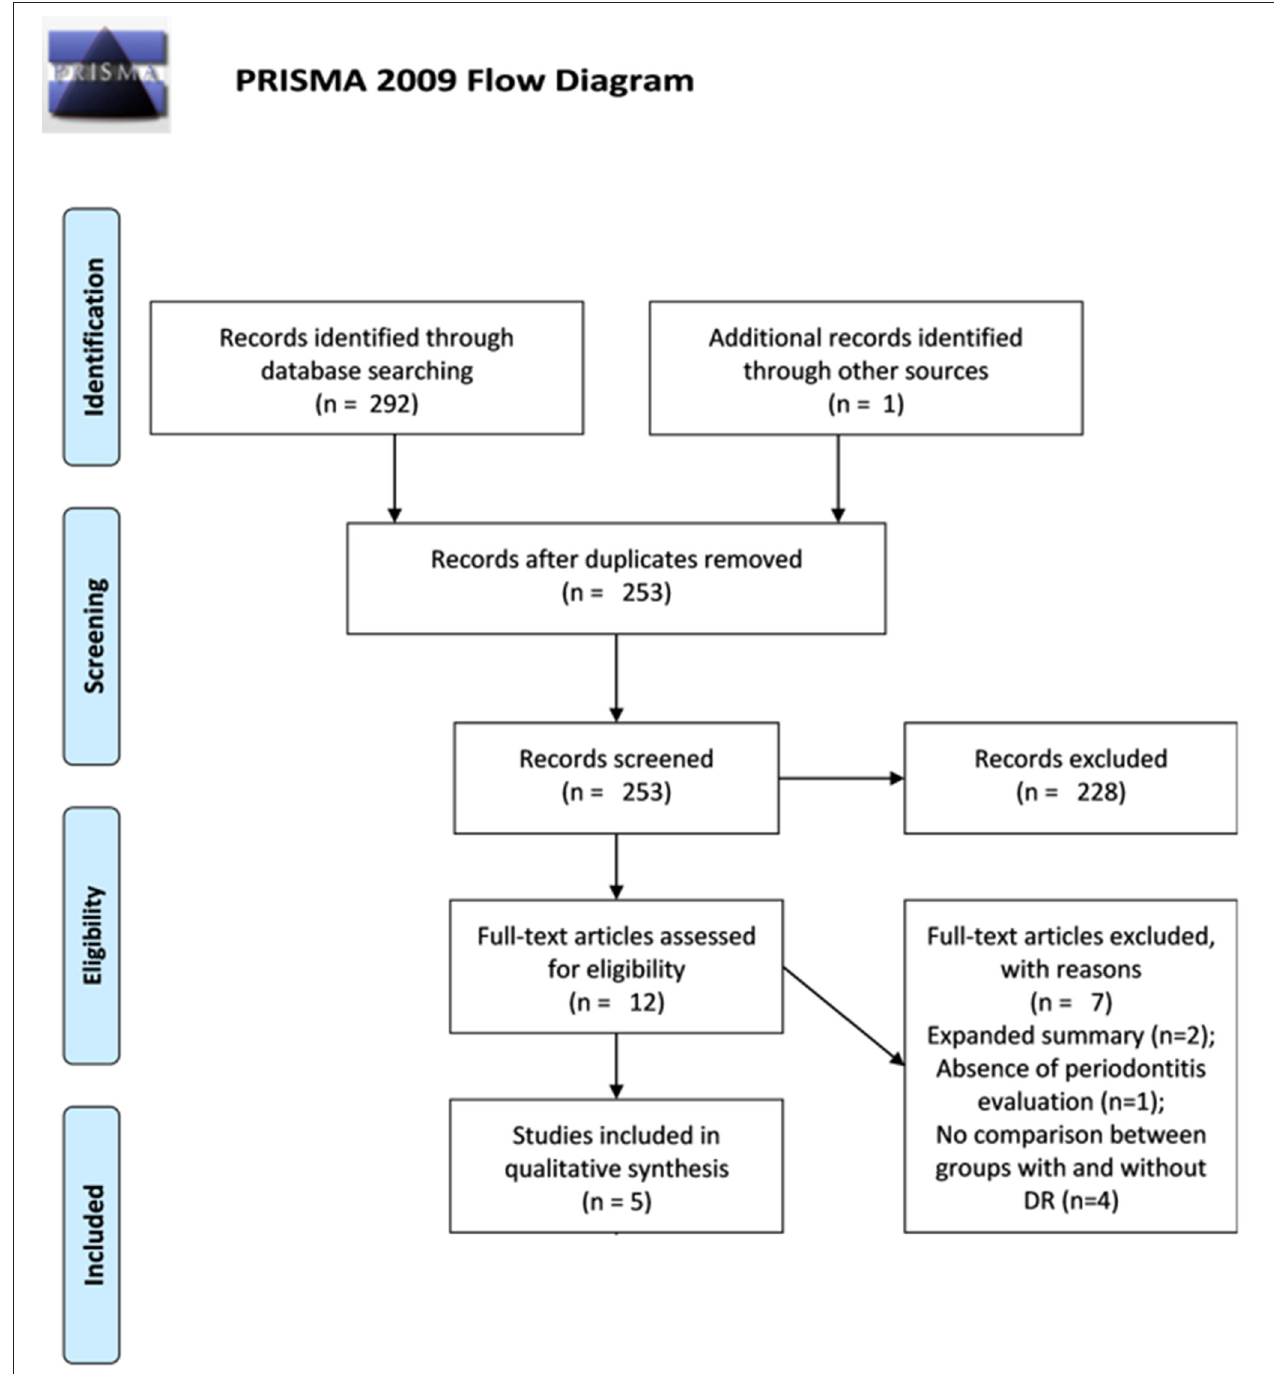
FIGURE 1 | Preferred reporting items for systematic review and meta-analysis (PRISMA) flow diagram. The flow diagram depicts the flow of information through the different stages of this systematic review: the number of records identified, included and excluded, and the reasons for exclusions.